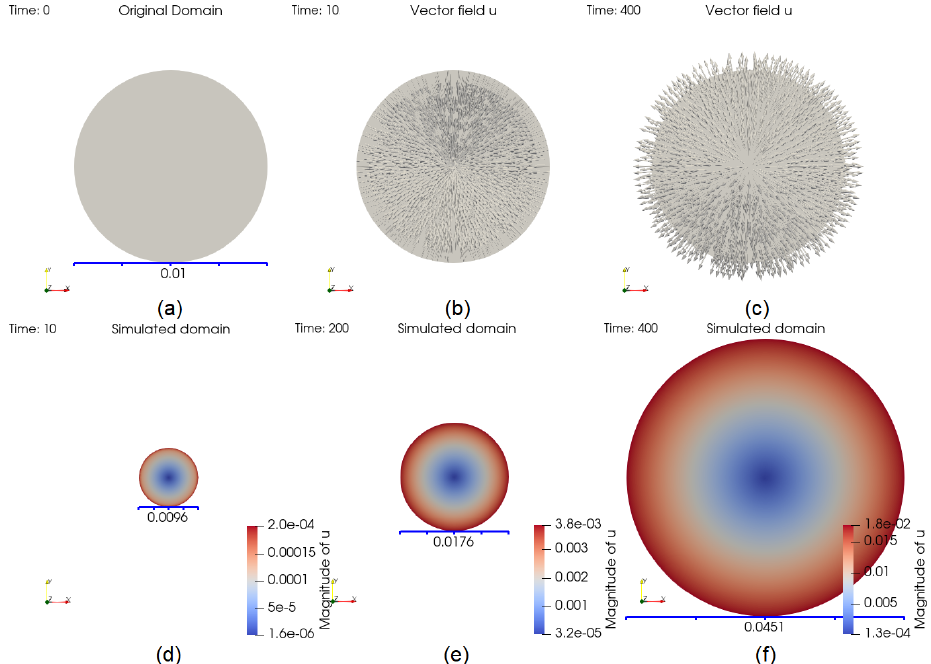
Figure 3. Evolution of the domain. The original domain is plotted in ( a ). At t = 10, the arrows, showing the vector field u , are pointing inward, since V is decreasing in ( b ) whereas in ( c ), they are pointing outward since V is increasing, which means that the domain is growing at t = 400. Part ( d – f ) show the size of the domain at time t = 10, 200, and 400,